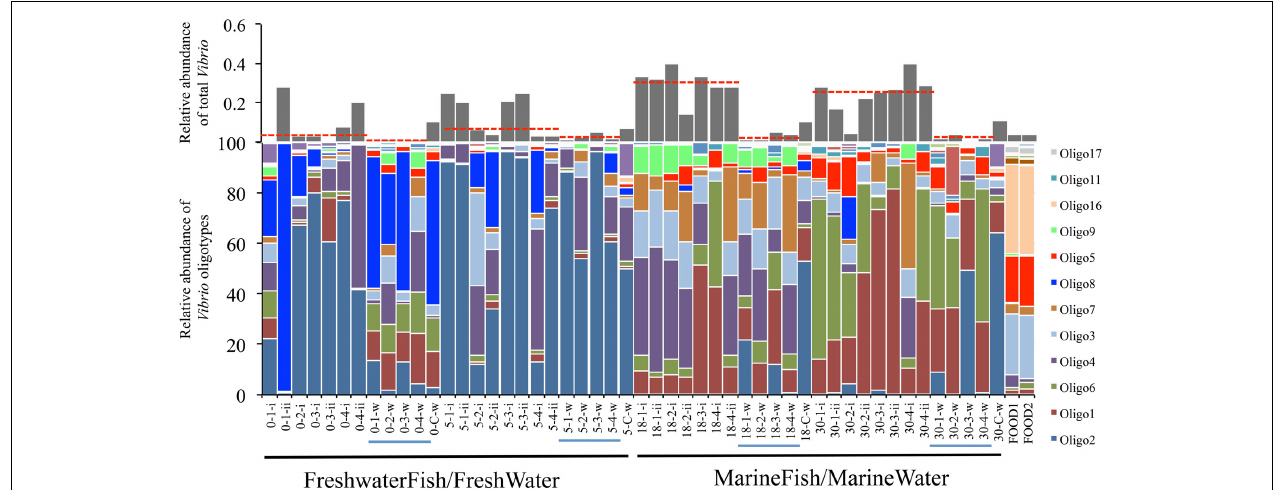
FIGURE 3 | Oligotype distribution for FreshwaterFish and MarineFish tissue (FreshwaterFish: 0-x-i and 5-x-ii, MarineFish: 18-x-i and 18-x-ii), associated water samples (x-x-W, blue lines), and water samples from aquaria containing no fish (x-C-W). The relative abundance of each oligotype within the total Vibrio diversity for each sample is shown in stacked bar graphs (bottom), and the proportion of the total Vibrio (relative abundance) within all bacterial diversity for each sample is shown with gray